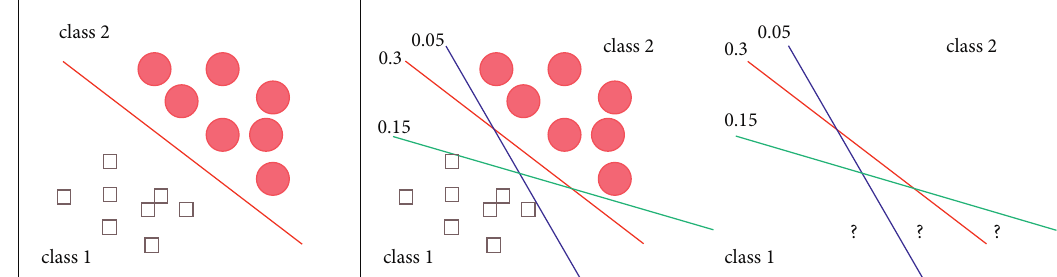
Figure 2: Different types of linear plane